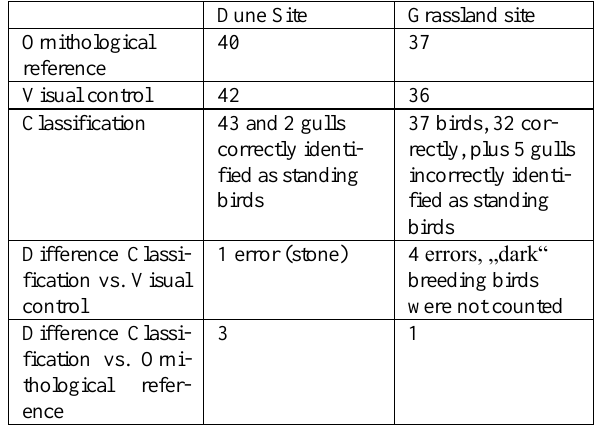
Table 2. Reference counts and classification accuracy